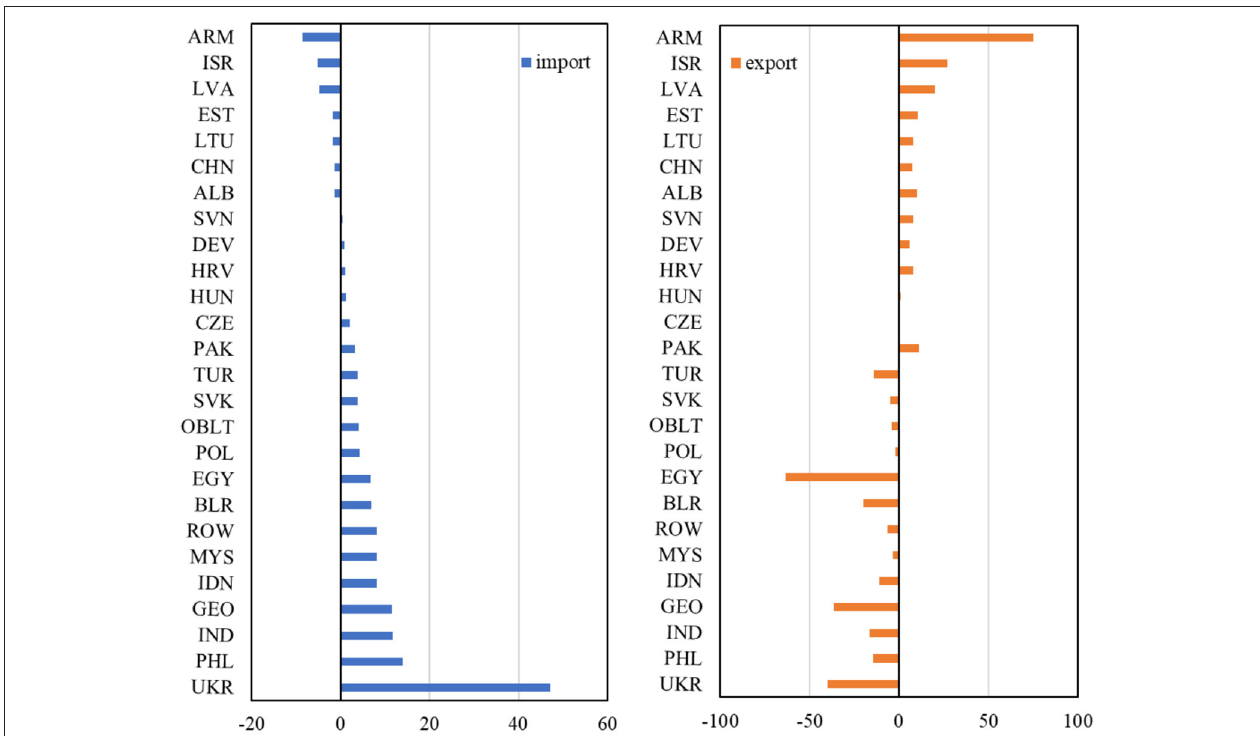
FIGURE 2 | Changes in digital industry exports and imports by region in S3 simulation (unit: %). Data sources: GTAP model